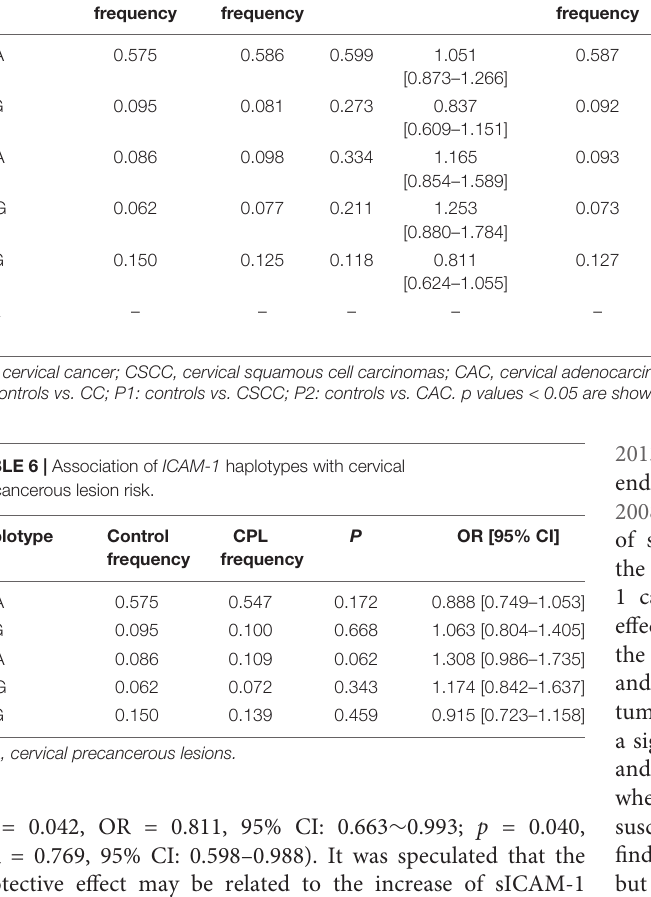
TABLE 5 | Association of ICAM-1 haplotypes with cervical cancer risk. Haplotype